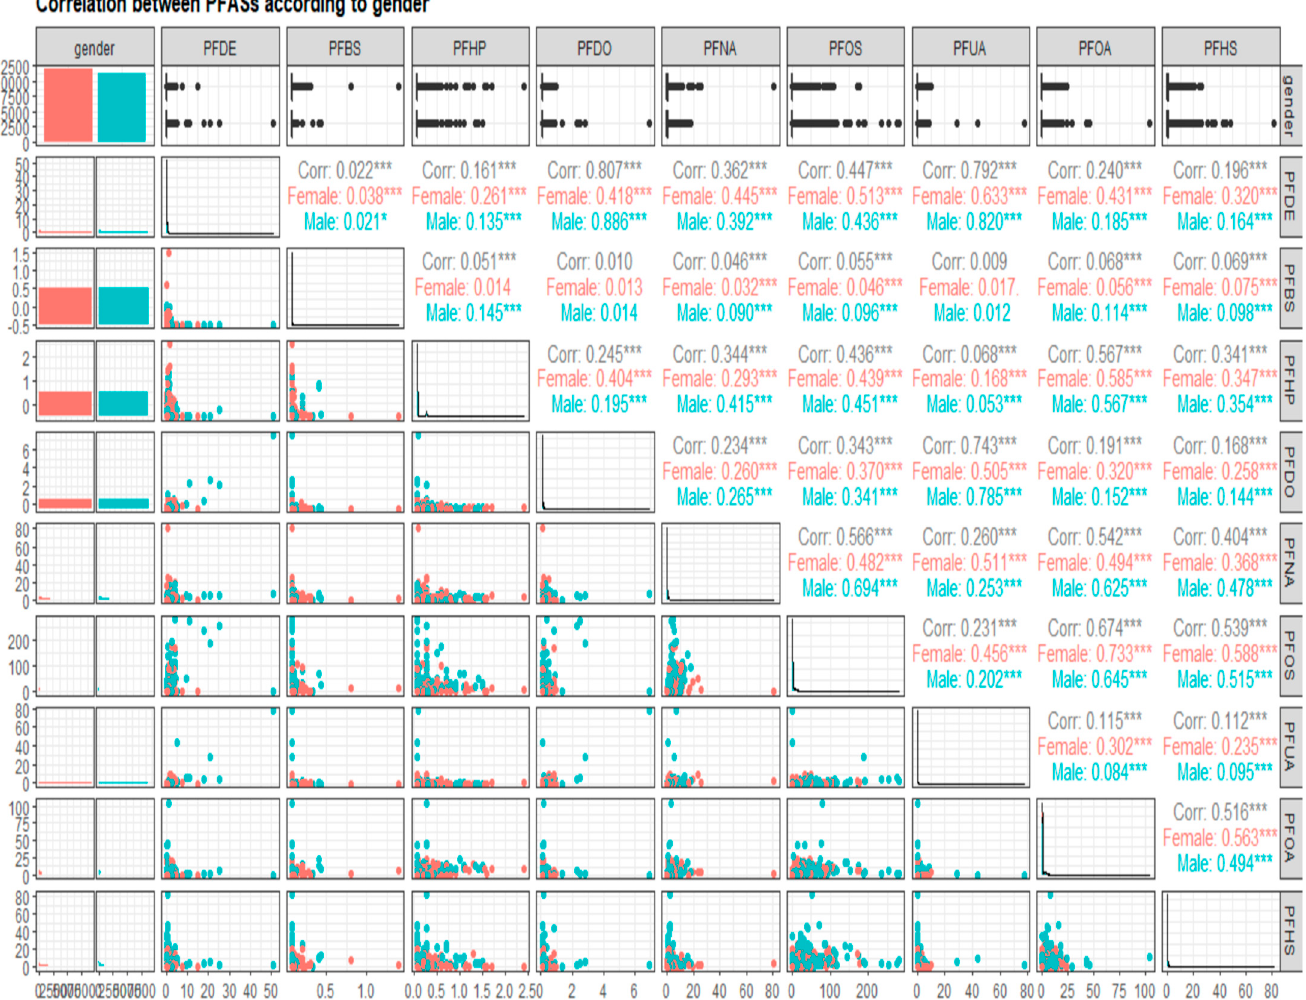
Figure 1. Pair plots showing correlations between selected PFAS by gender. PFAS were measured in micrograms per liter ( µ